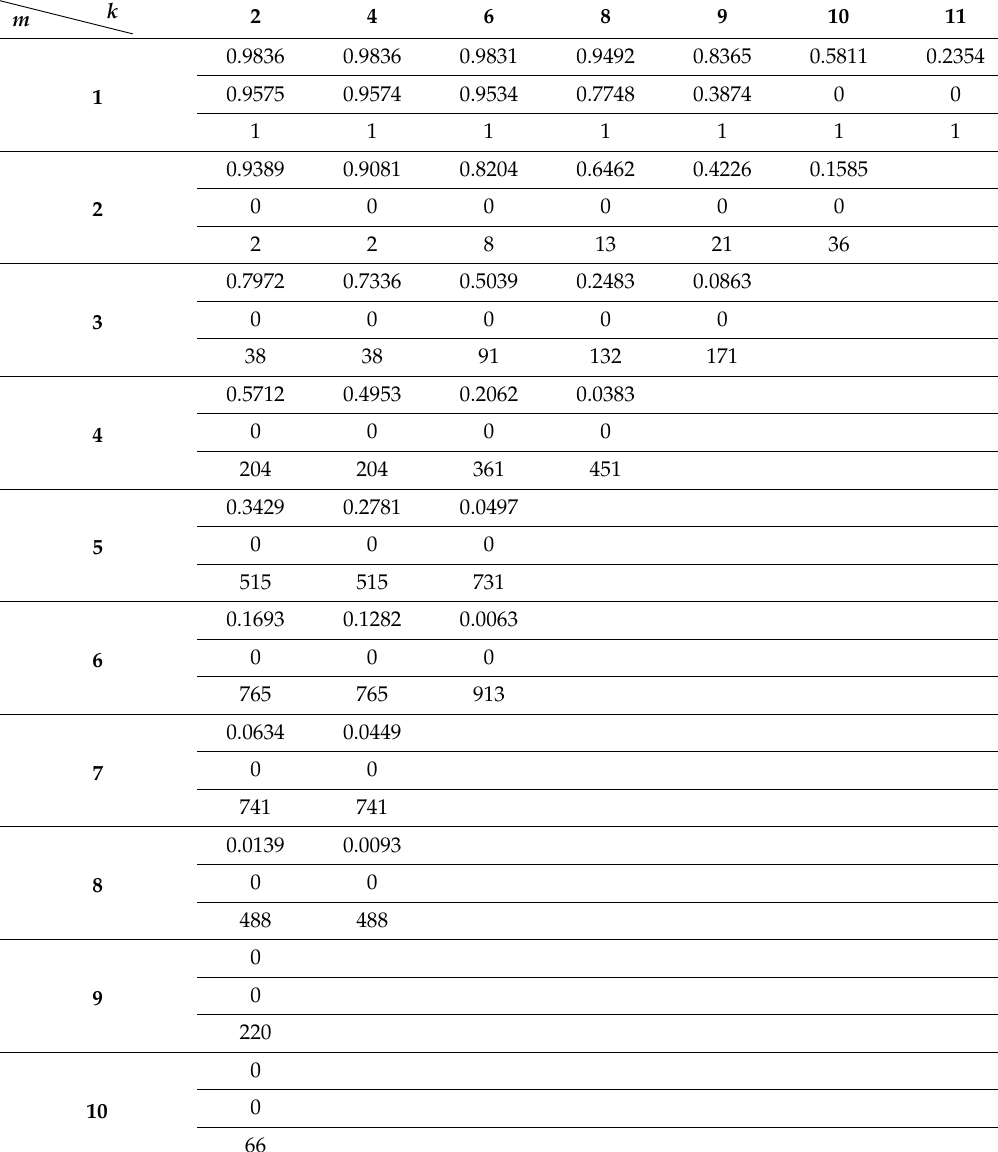
Table 1. The mean and minimum value of survivability for different m- and k- values and the number of initial failure node groups that provide the system with minimal survivability. (The first parameter indicates the mean survivability. The second parameter indicates minimum survivability. The third parameter indicates the number of node